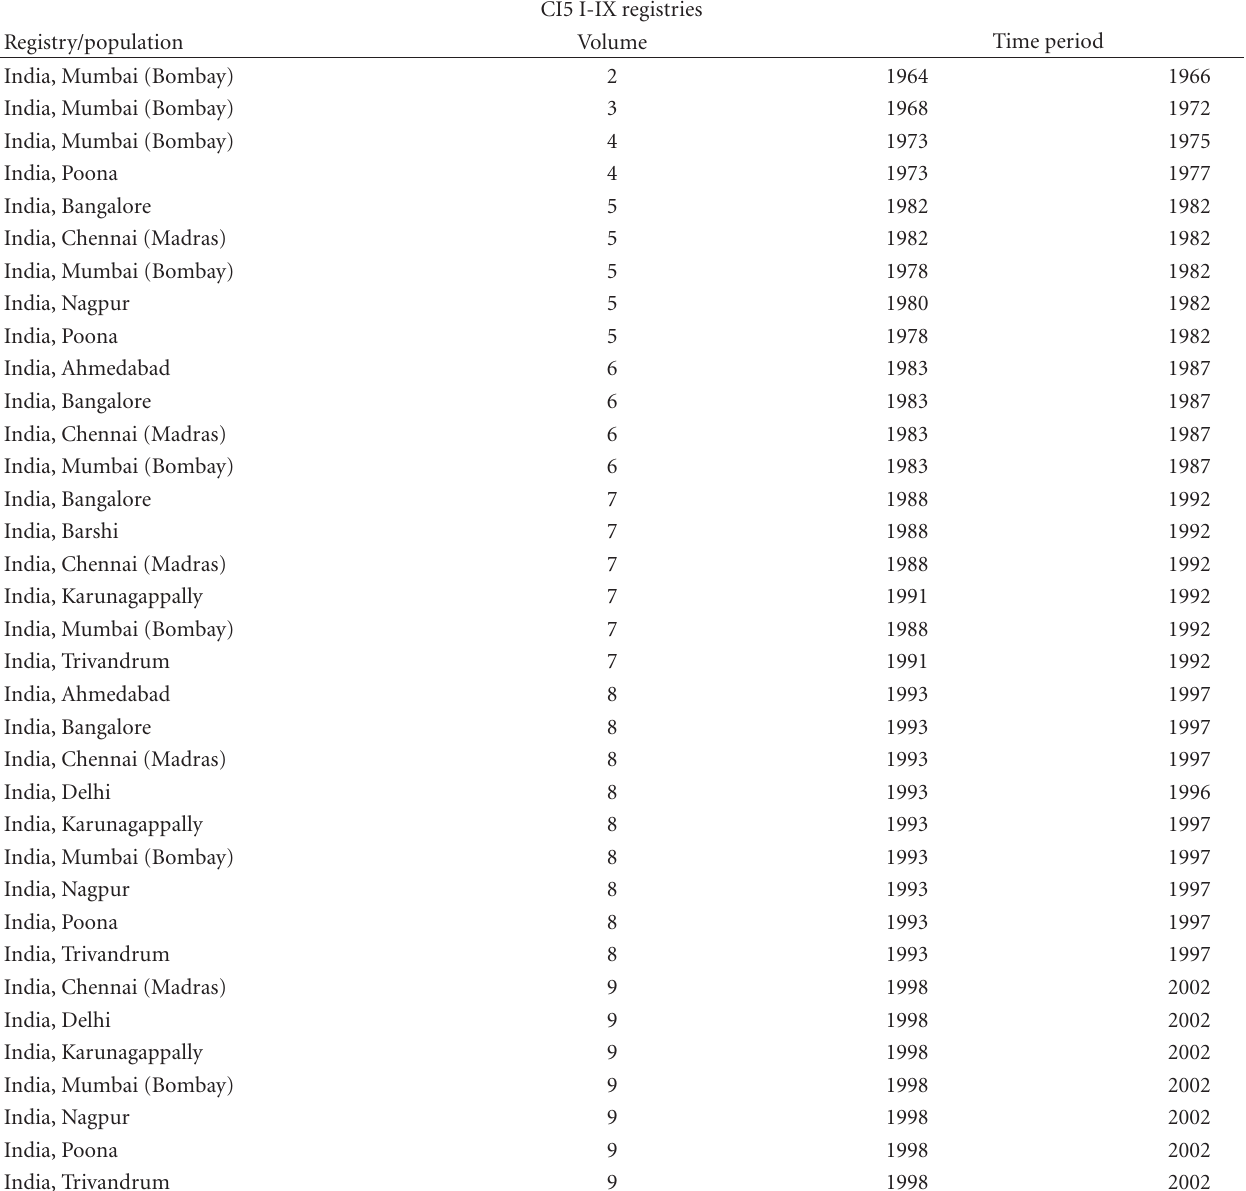
Table 4: Summary of Indian cancer registries reported by IARC, CI5